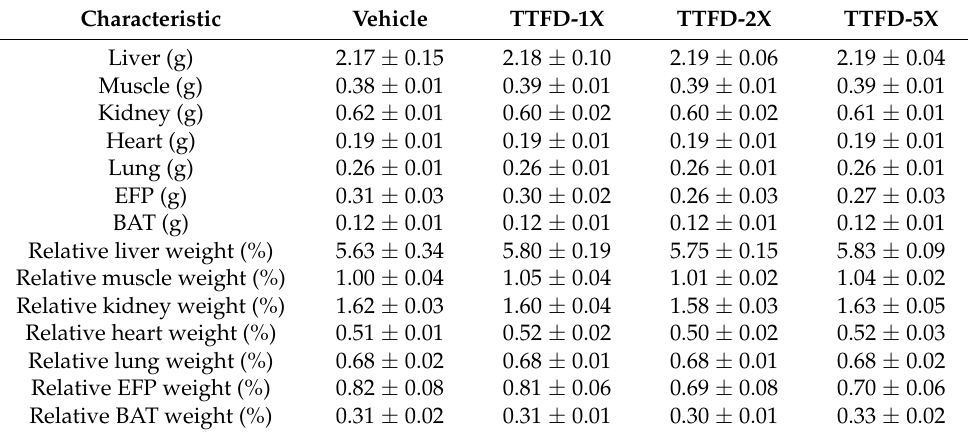
Table 3. Effects of TTFD on body compositions.